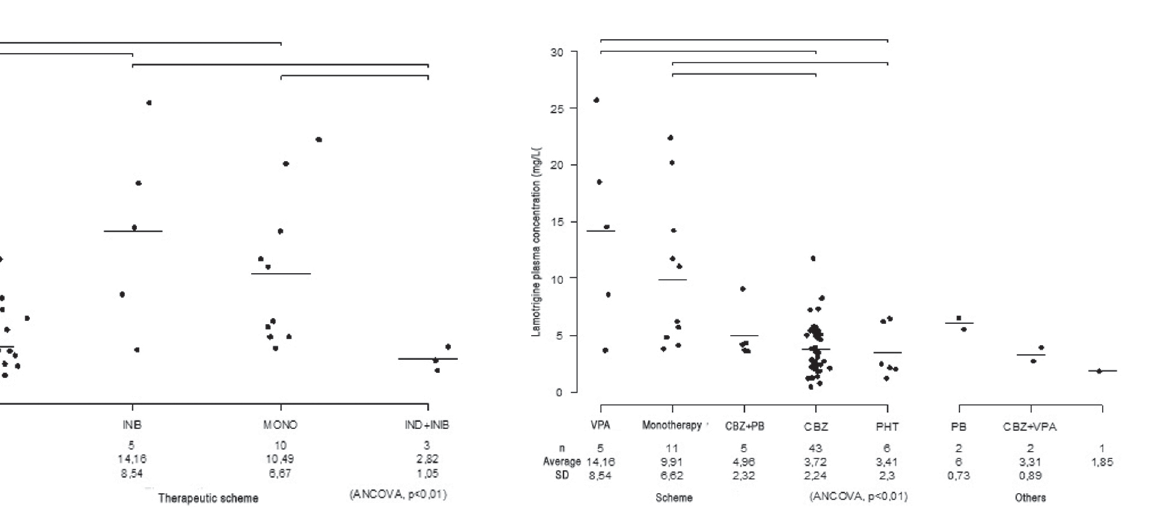
FIGURE 1 - Comparisons among the mean LTG plasma concentrations considering the co-medication groups (n=75). (IND: inducers; INI: inhibitors; MONO: monotherapy; SD: standard deviation). Horizontal lines at the top of the graph indicate pairwise significant differences between the groups.